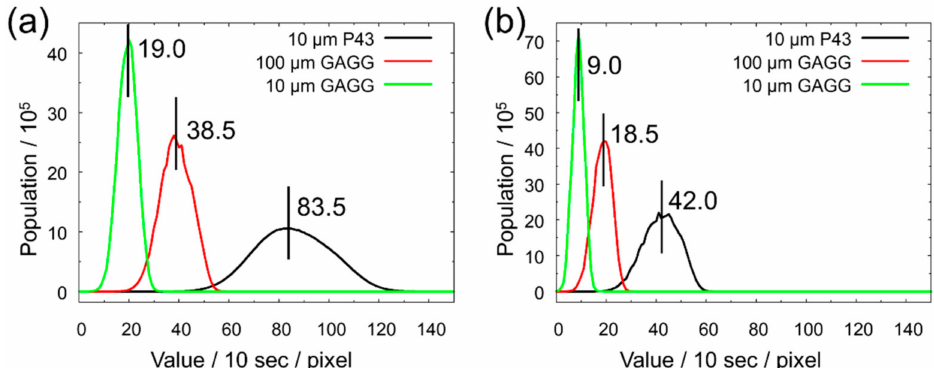
Figure 5. Histograms of open-beam intensity taken at 2 × magnification with scintillators P43 (10 µ m), GAGG (100 µ m), and GAGG (10 µ m): ( a ) L / D = 180 and ( b ) L / D = 300. The position and value of the median are shown in the